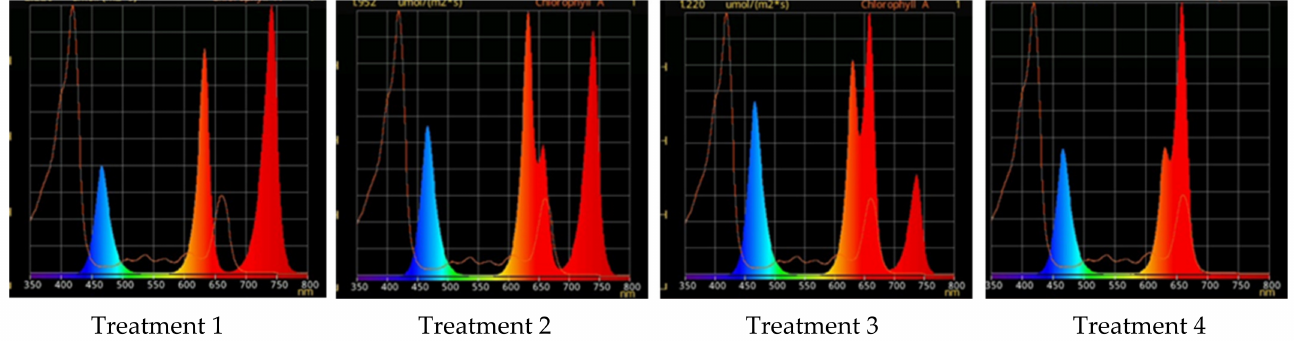
Figure 1. Light treatment spectra, relative portion of red, λ max = 660 nm (R 660 ), and far-red, λ max = 739 nm (FR), in their combination: Treatment 1—0% R 660 + 100% FR; Treatment 2—30% R 660 + 70% FR; Treatment 3—70% R 660 + 30% FR; Treatment 4—100% R 660 + 0%